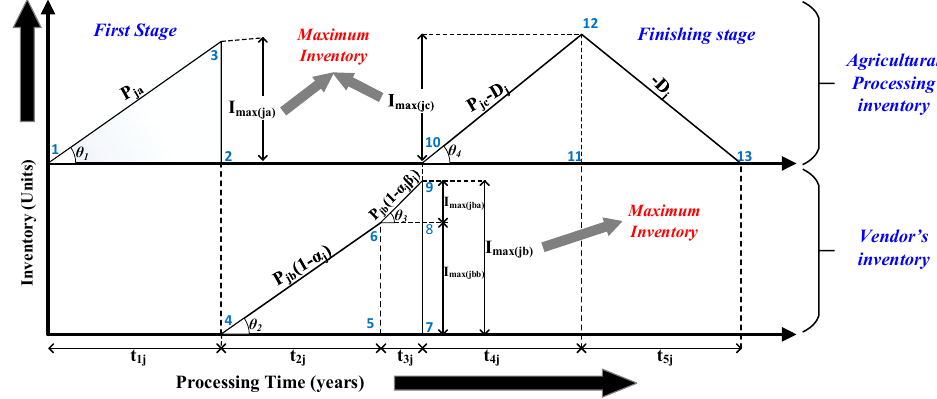
Figure 1. The inventory diagram of the agricultural supply chain management (Agri-SCM).